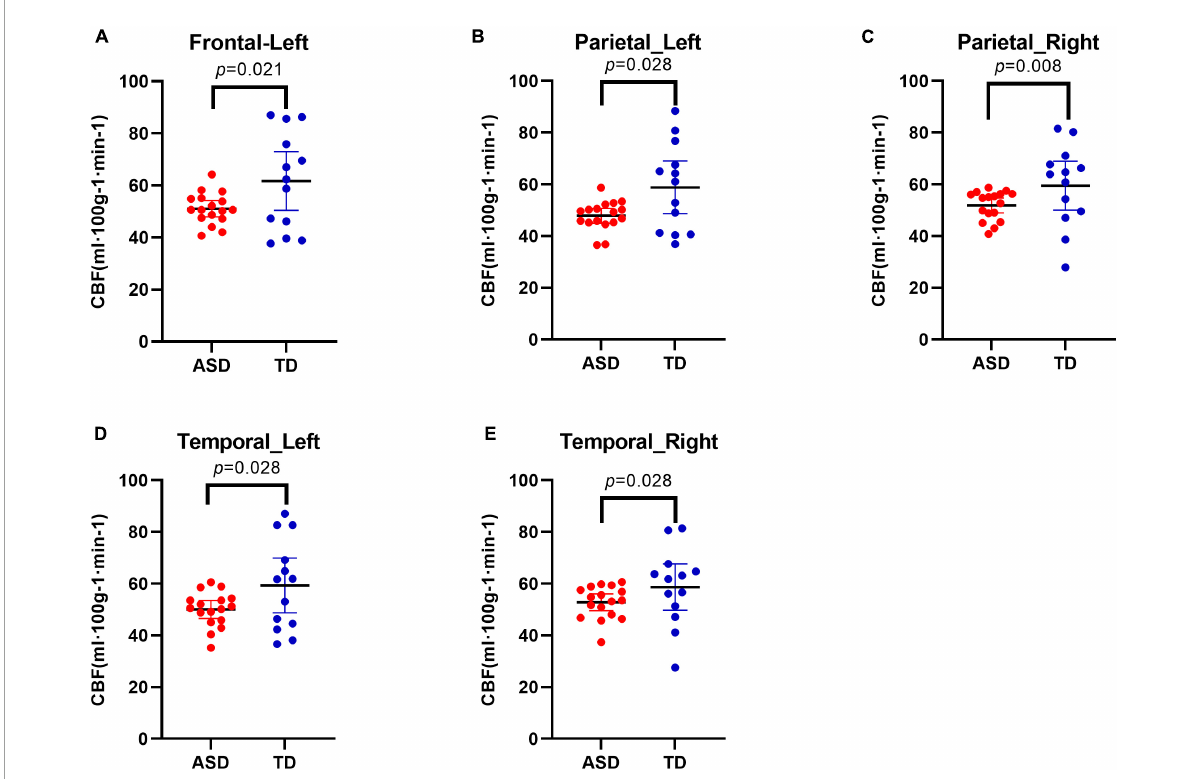
FIGURE2 Decreased cerebral blood flow (CBF) in different regions in Autism Spectrum Disorders (ASD) group compared with typically developing (TD) group. Results showed decreased CBF in the left frontal lobe (A) , in the bilateral parietal lobes (B,C) , and in the bilateral temporal lobes (D,E) .